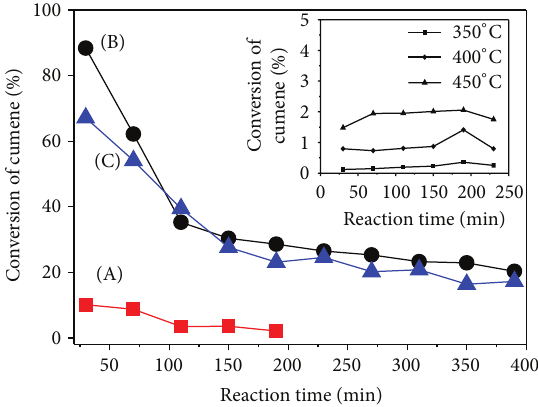
Figure6:Thecumenecatalyticreactionperformanceofthesamples and the thermal cracking without catalyst (insert). (A) HY-0-12, (B) HY-0.67-48, and (C)